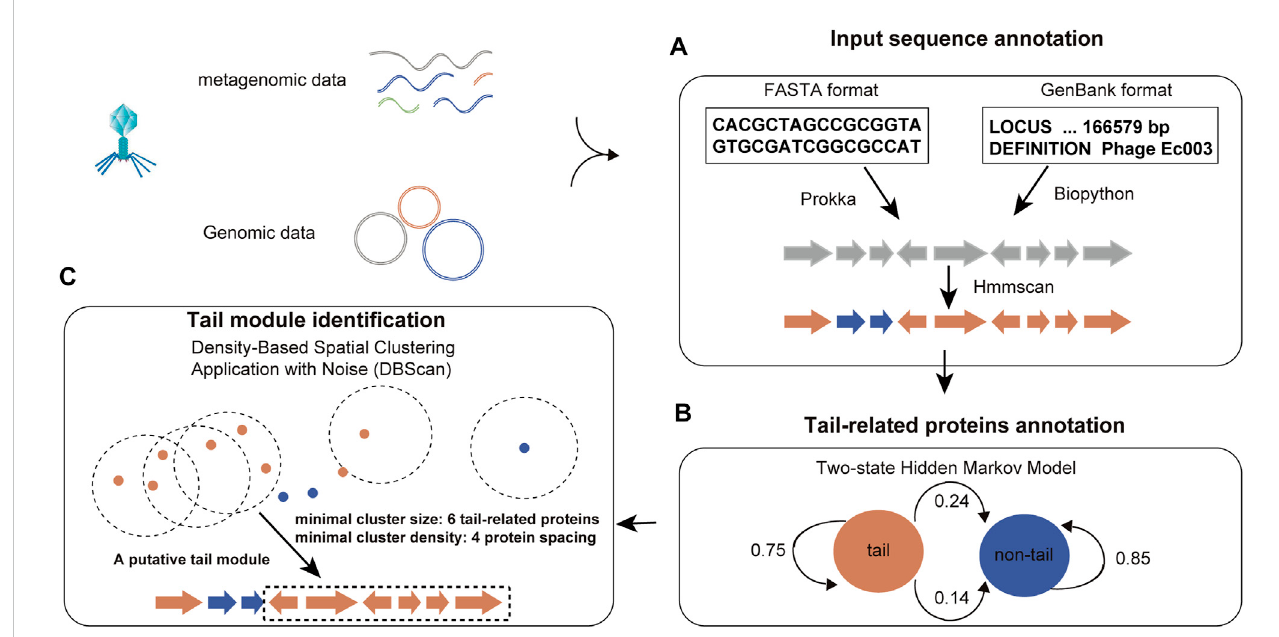
FIGURE 2 Flowchart of the PhageTailFinder. Flowchart illustrating the three-step tail module identi fi cation pipeline. (A) Annotating proteins in the phage genome and converting protein sequences into a string of Pfam domains. (B) Calculating posterior probabilities of the tail and non-tail hidden states to predict tail- related proteins. (C) Clustering the tail module using